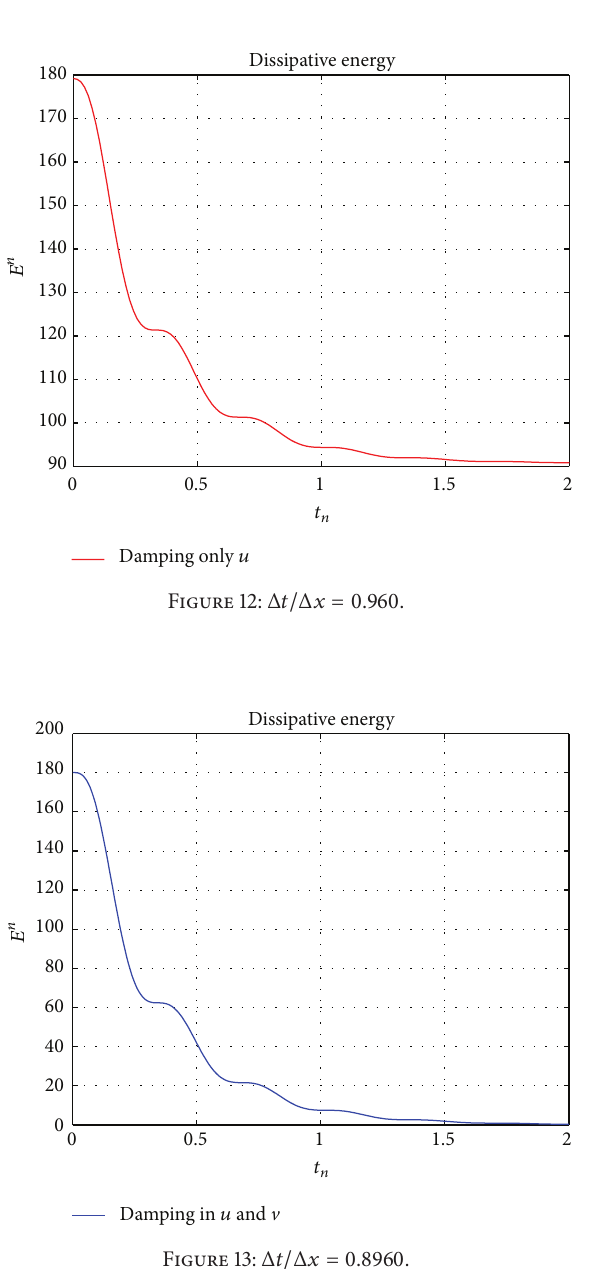
Figure 13: Δ𝑡/Δ𝑥 = 0.8960 .